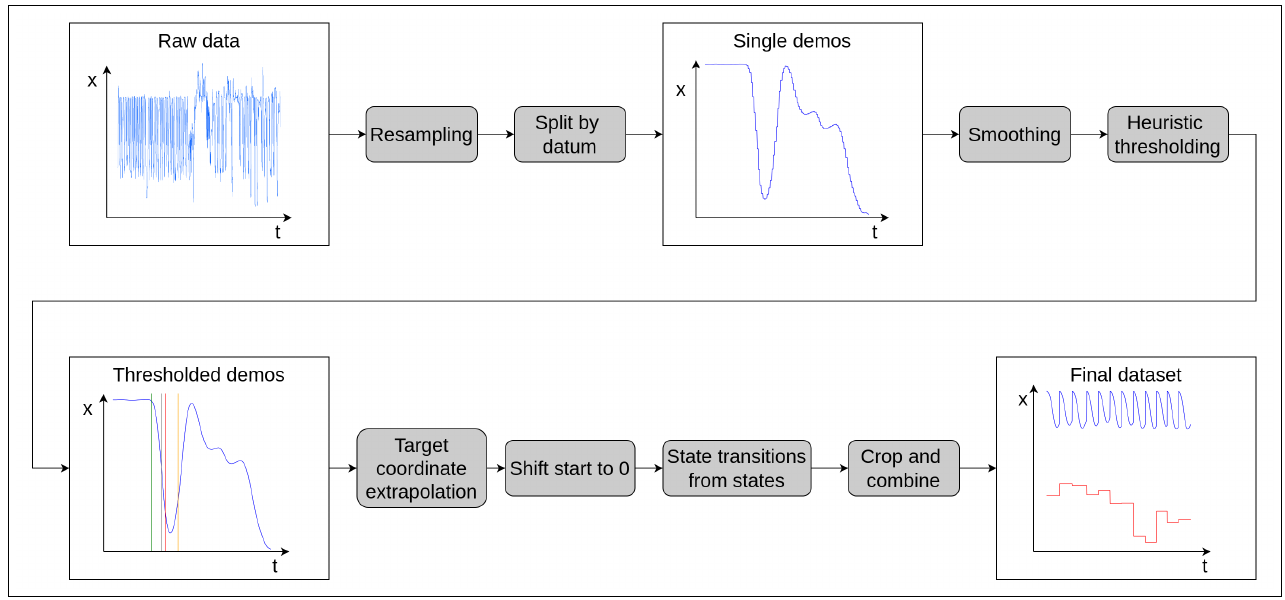
Figure 3. Pre-processing pipeline overview. All charts are purely illustrative and show effector x -axis position with respect to time (in blue). The final diagram also shows the target x -coordinate of each discrete demonstration (in red). The thresholds are, from left to right: movement, release, freefall start and freefall